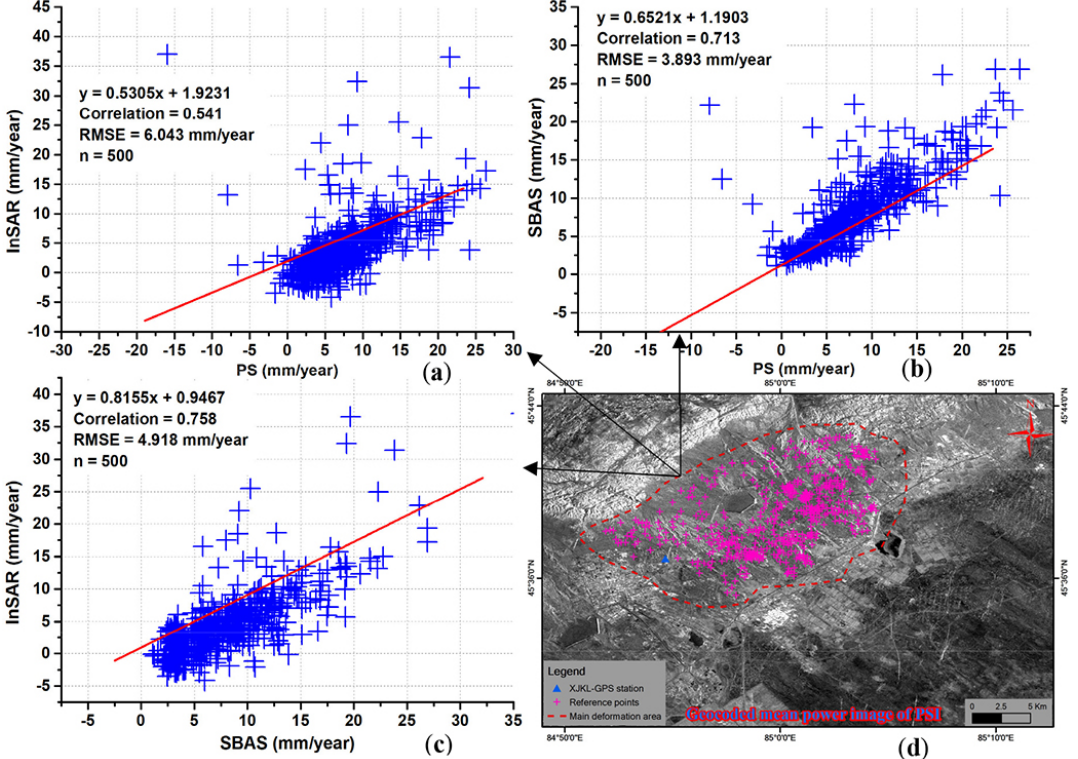
Figure 9. Comparison of mean deformation velocity among D ‐ InSAR, PS ‐ InSAR and SBAS ‐ InSAR methods ( a – c ) for the selected locations, shown as pink cross lines, in ( d ), showing the distribution of the selected 500 reference points. The blue triangle denotes the location of previous GPS station [36].